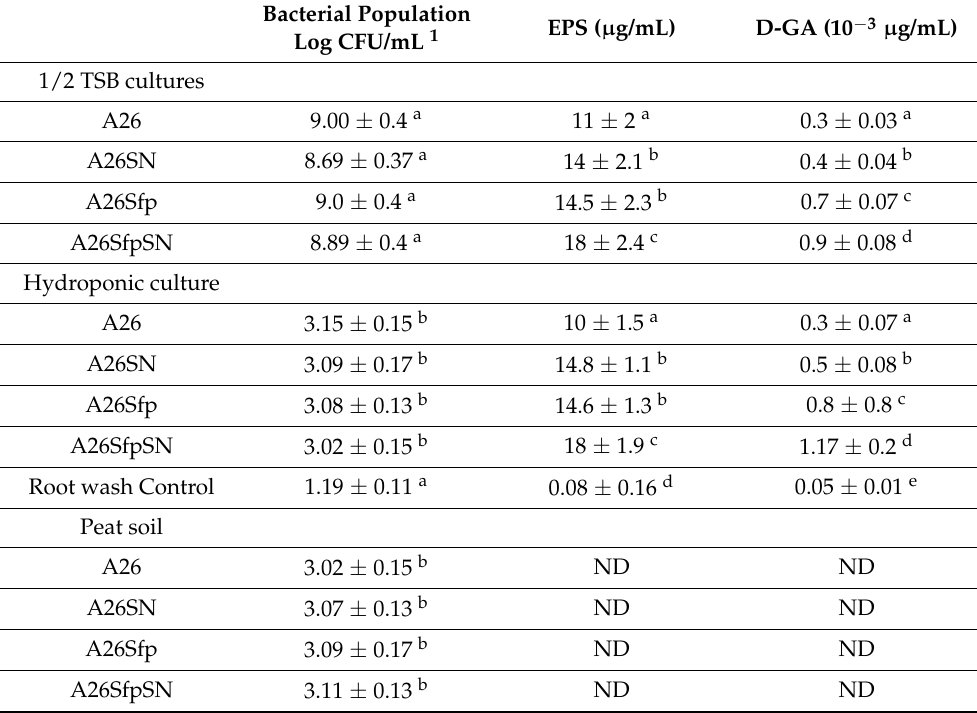
Table 2. EPS and D-GA assessment in relation to bacterial